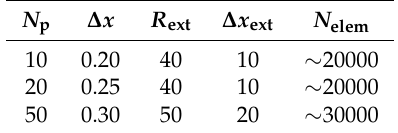
Table 1. Mesh and geometrical parameters used in the